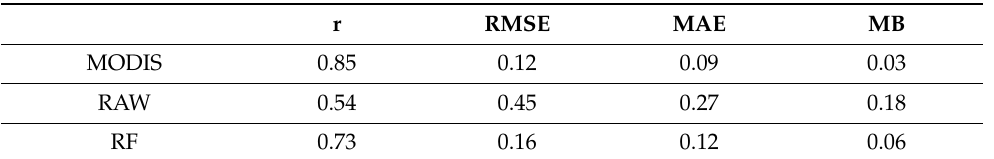
Table 3. Correlation and residuals of 330 AOD estimations on testing dates that are collocated with the 8 AERONET